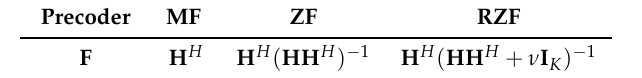
Table 1. The precoding matrices of MF (matched filtering), ZF (zero-forcing), and